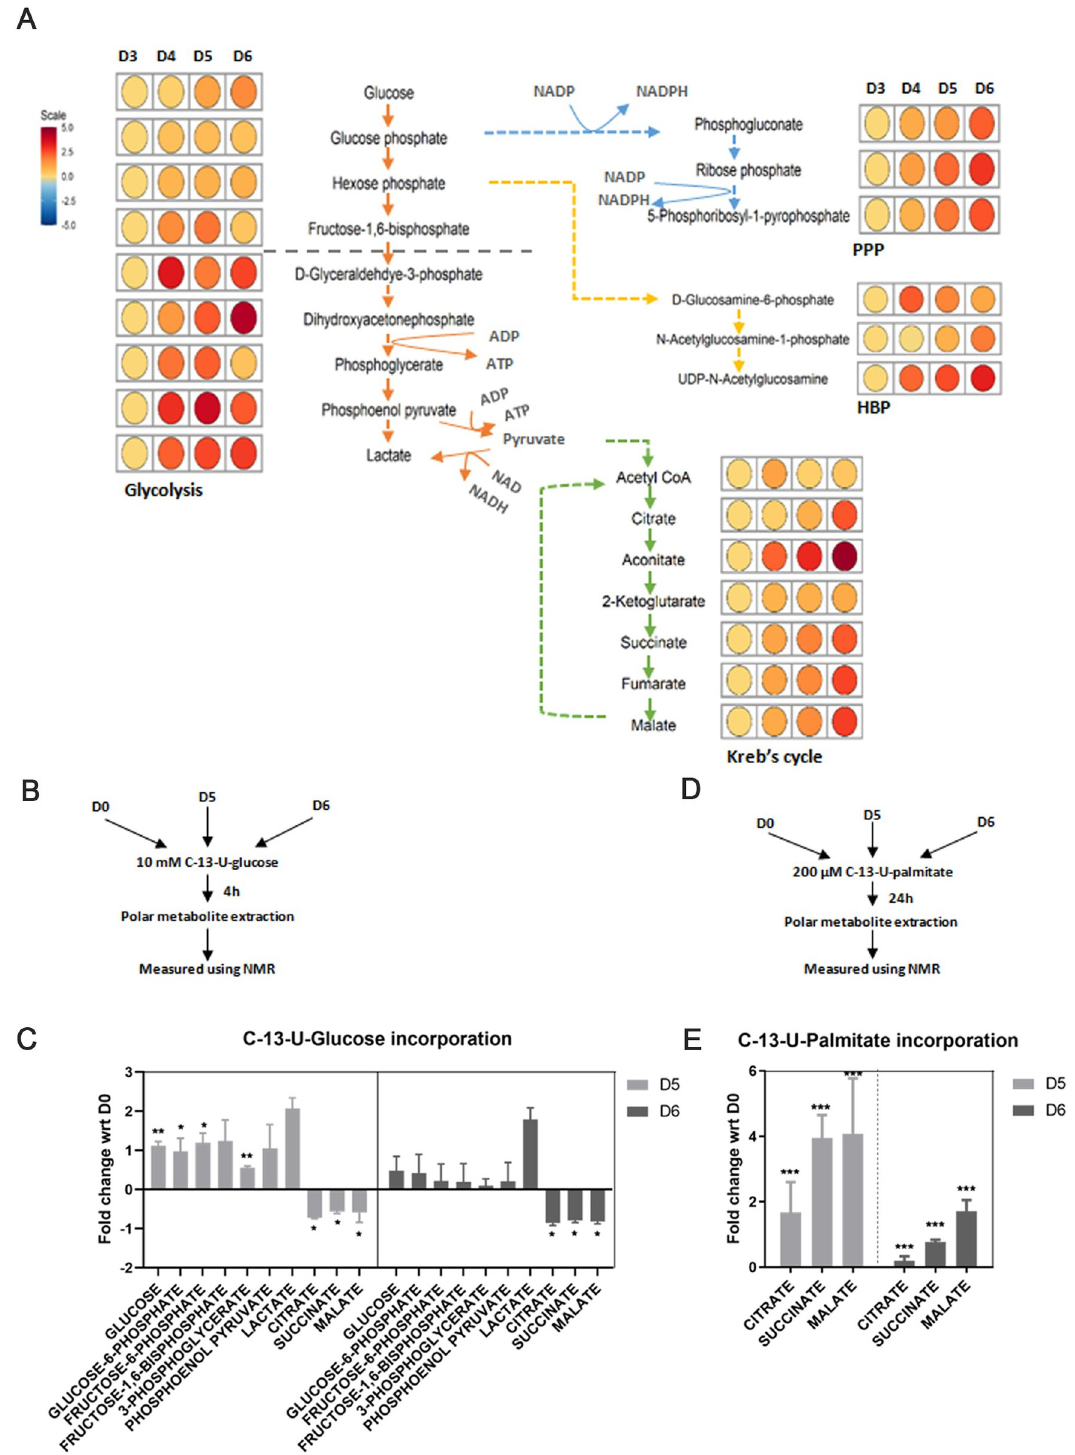
Fig 3. Partial uncoupling of glycolysis and TCA supports biosynthesis pathways (PPP, HBP) while FAO increases to sustain TCA. (A) Liquid chromatography-coupled tandem mass spectrometry-based metabolomic analysis is performed for polar metabolites extracted from D3 to D6 for 4 independent replicates. Metabolic network is drawn for glycolysis, Kreb’s cycle, PPP, and HBP by comparing their metabolite levels across D3 to D6. Fold changes are plotted as heatmaps along each metabolite in the pathway with respect to D3. Scale bar ranges from blue to red corresponding to metabolite change from –5 to +5 fold. ( B)